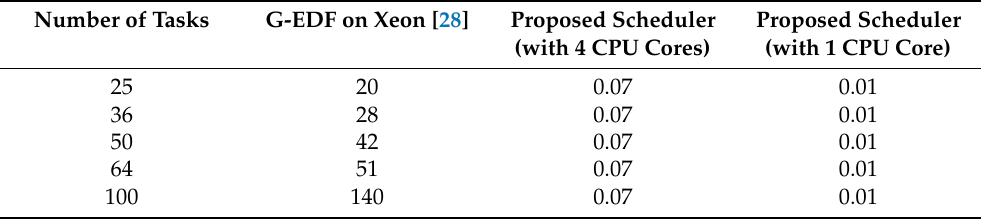
Table 4. Worst-case CPU overhead of task scheduling comparison in microseconds